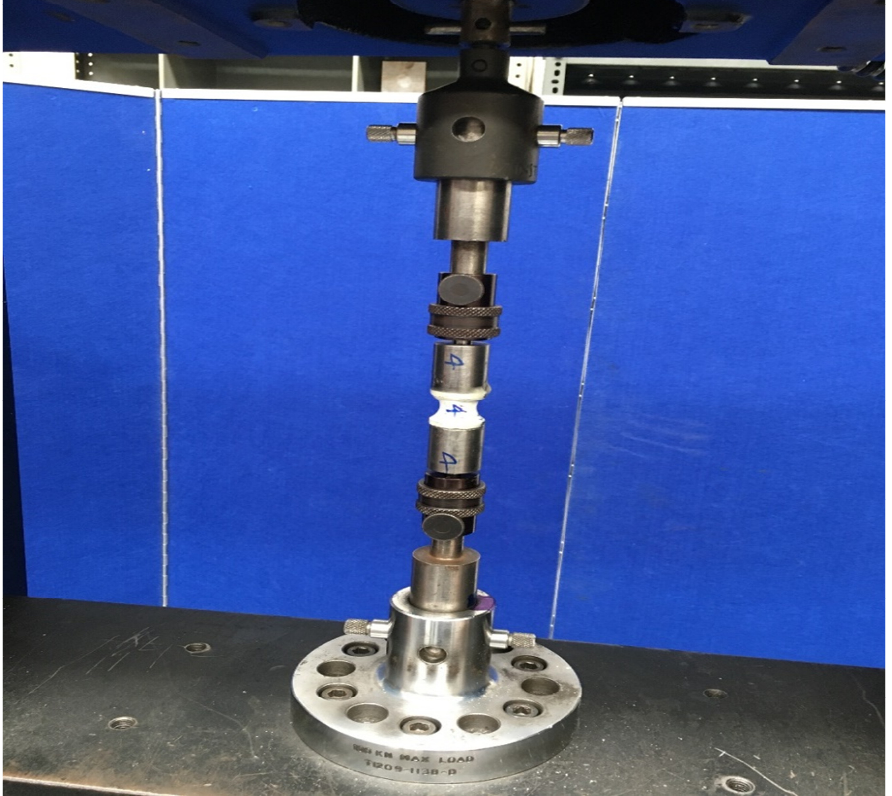
Figure 4. Through-thickness sample during testing in the tensile machine.